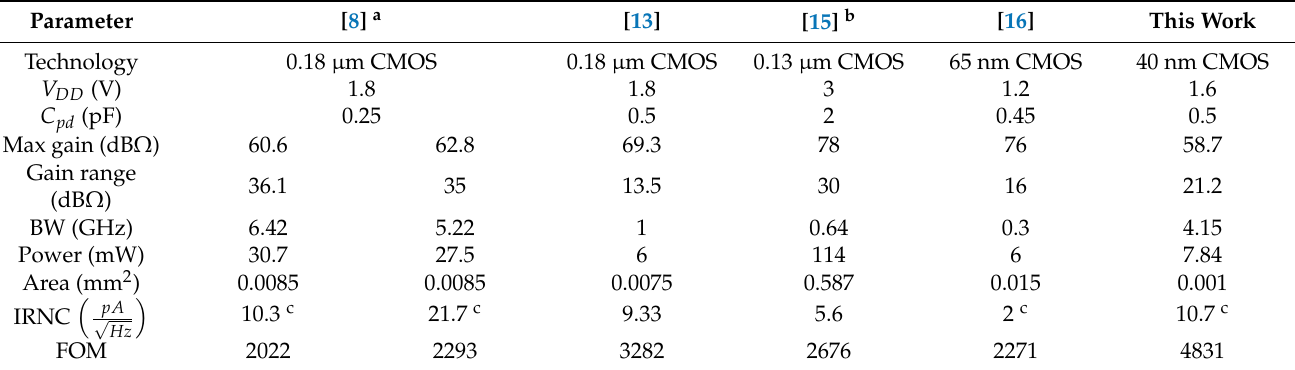
Table 3. Table of comparison of this TIA design with other recent